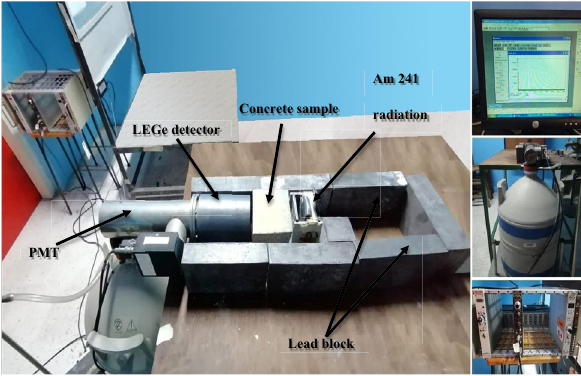
Figure 5: The test stand of γ rays, adapted from ref. [ 8 ]